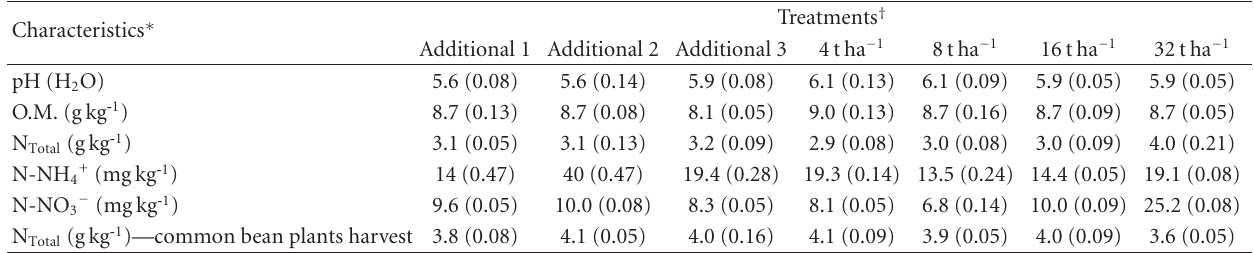
Table 3: Chemical and physical soil characteristics before common bean plants cultivation.